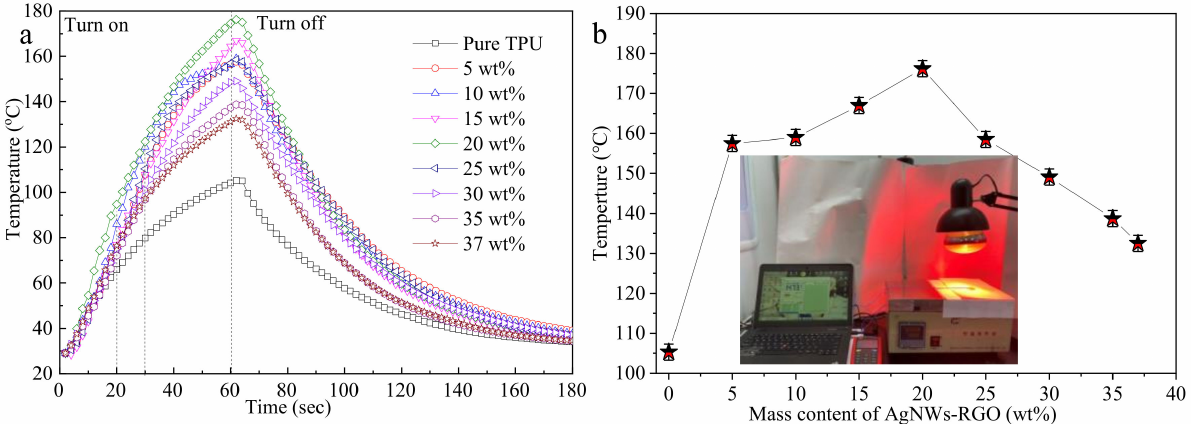
Figure 9. Temperature of the composite films containing different AgNWs-RGO mass contents under IR light irradiation ( a ) and the temperature of the composite film irradiated for 1 min ( b ). The inset in Figure 6b is a photograph of the testing